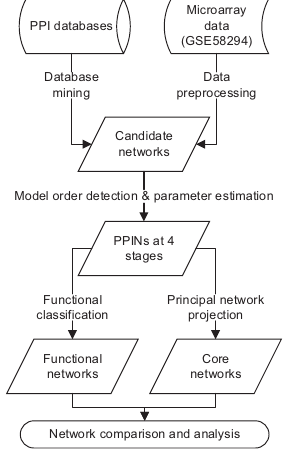
Figure 5. Flowchart of the early cardioembolic (CE) stroke model analysis process, consisting of data preprocessing, interaction network construction, principal network projection and comparative analysis of functional and core